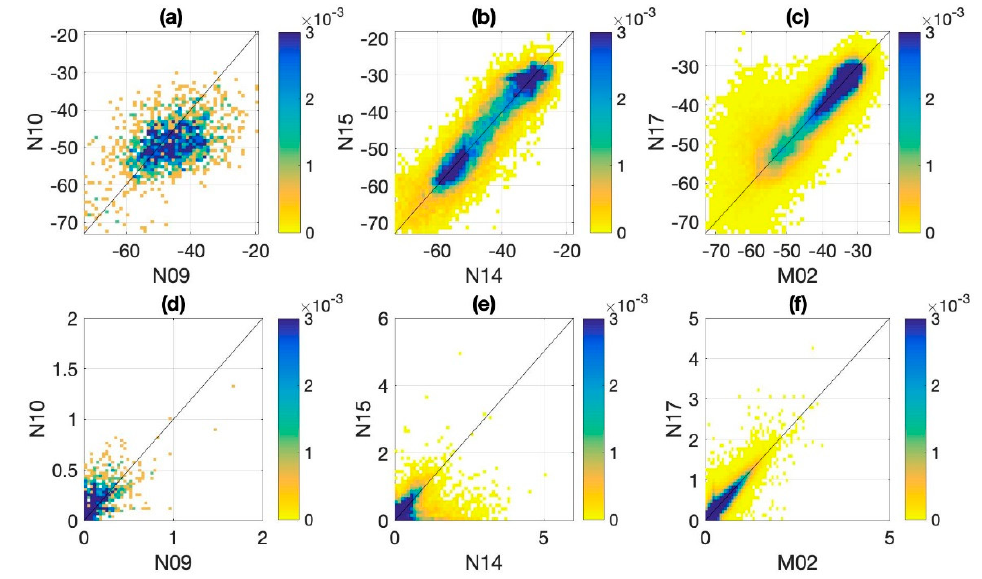
Figure 3. Histograms (normalized by count) of temperature (°C) at 300 hPa for ( a ) N-9 vs. N-10, ( b ) N-14 vs. N-15, and ( c ) M-02 vs. N-17. Histograms (normalized by count) of specific humidity (g/kg) at 400 hPa for ( d ) N-9 vs. N-10, ( e ) N-14 vs. N-15, and ( f ) M-02 vs. N-17.